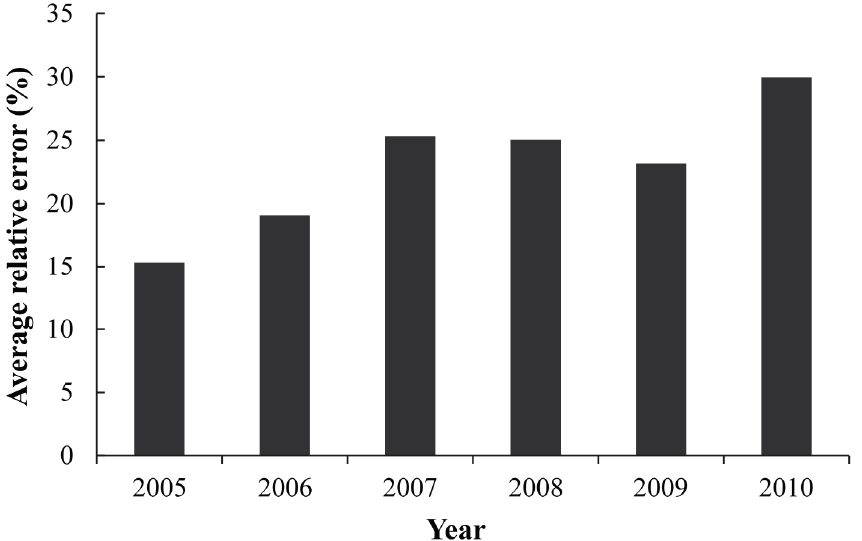
Figure 7. Average relative errors for each